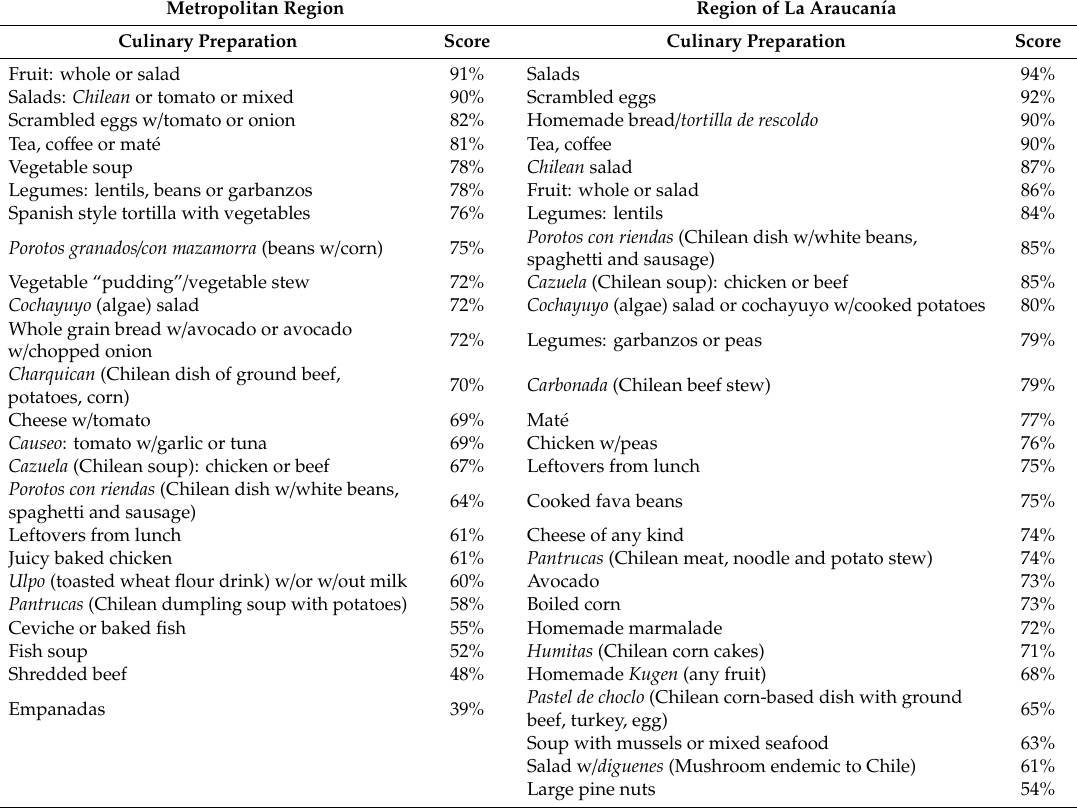
Table 5. Short list of traditional culinary preparations ranked by sustainability score by